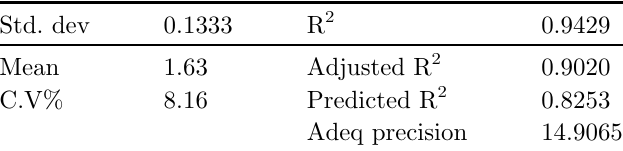
Table 7. Fit statistics.